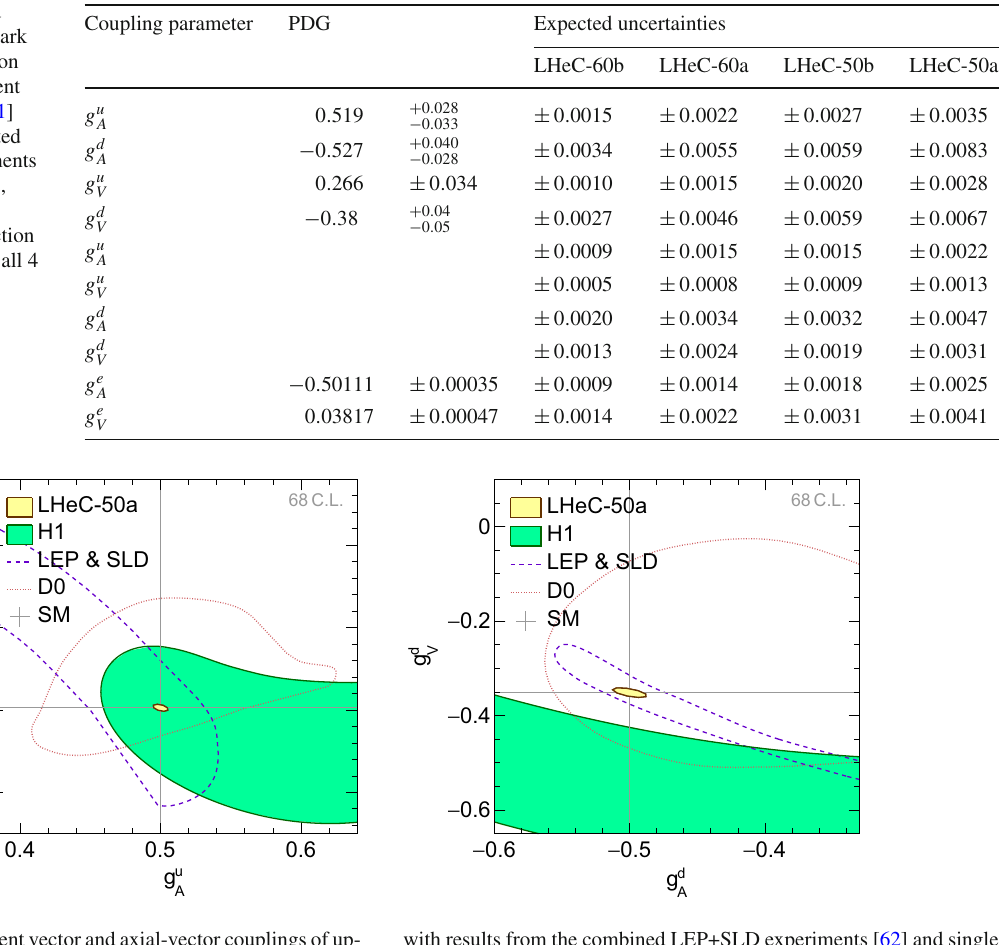
with results from the combined LEP+SLD experiments [62] and single measurementsbyD0[84]andH1[18].Thestandardmodelexpectations are at the crossing of the horizontal and vertical